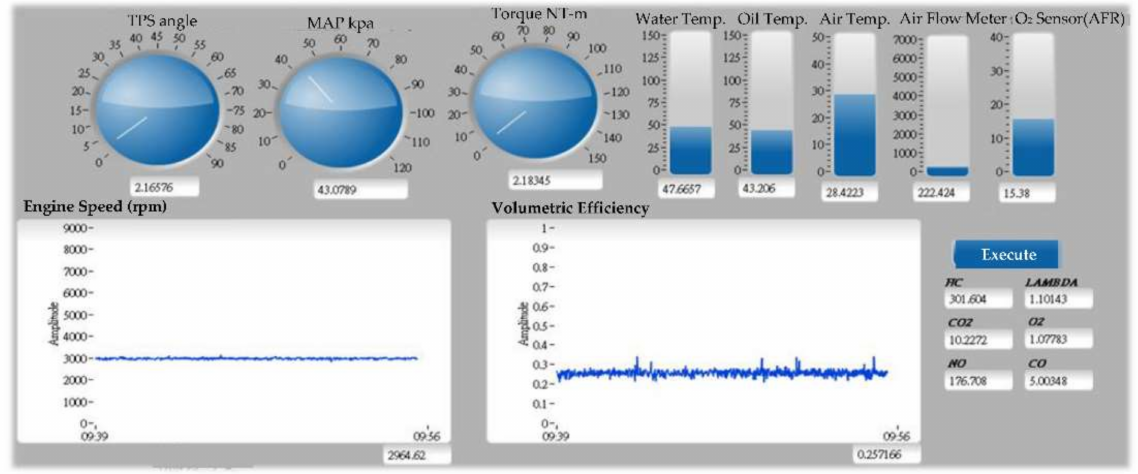
Figure 7. Virtual instrument test platform of the fuel injection control